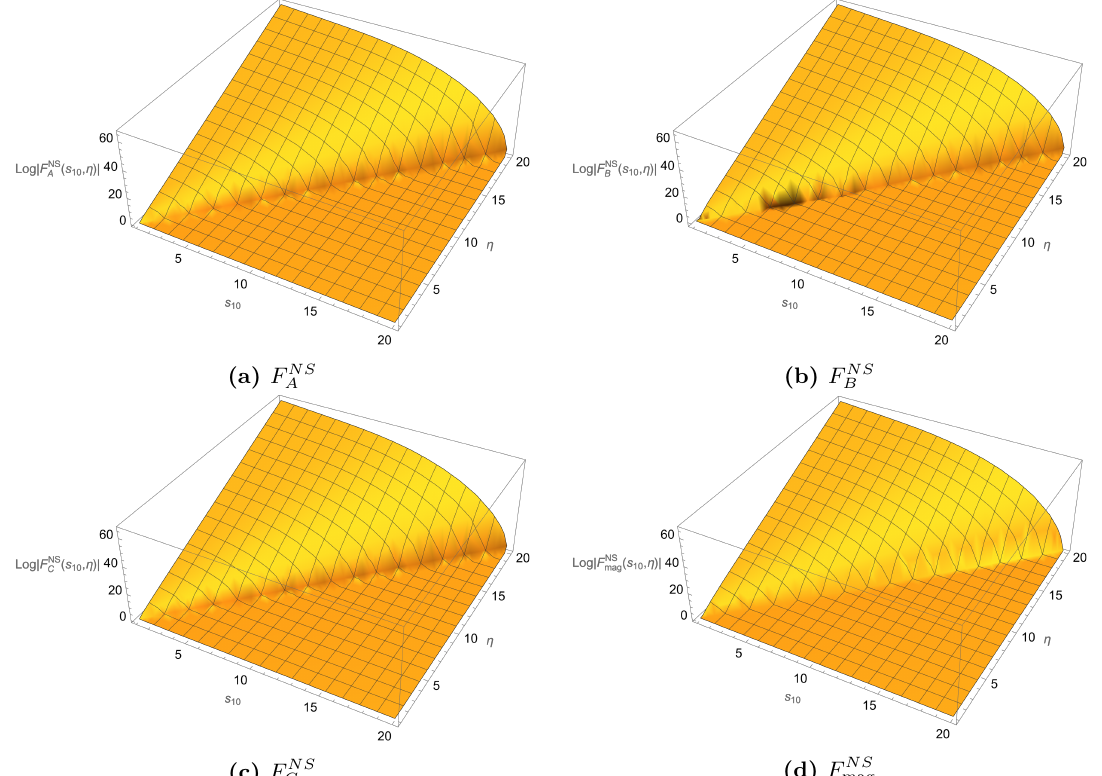
Figure 2. Plots of our numerical solutions for the dipole amplitudes numerically calculated at η max = 20 and ∆ η = ∆ s = η max /N = 0 . 033 . The plots depict the logarithm of the absolute value of each dipole amplitude as a function of variables η and s 10